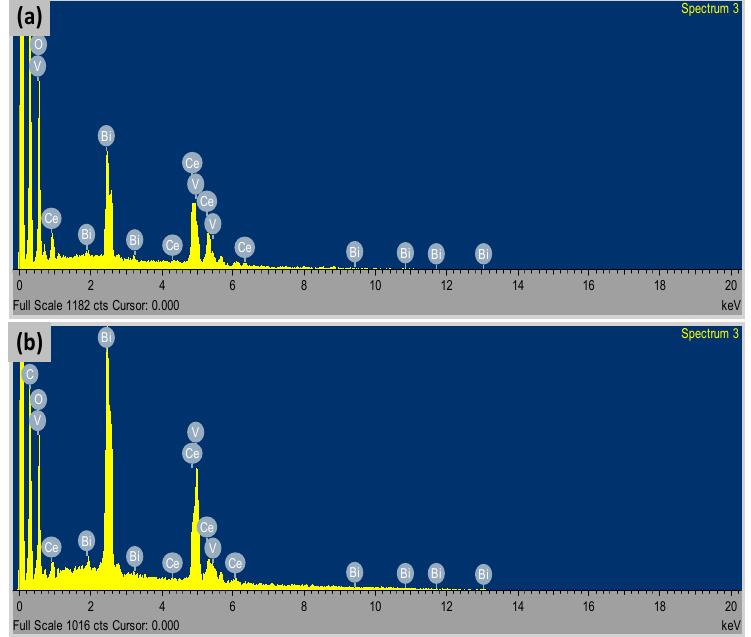
Figure 4. EDX of ( a ) Ce 2 O 3 /BiVO 4 , and ( b ) Ce 2 O 3 /BiVO 4 incorporated into rGO.